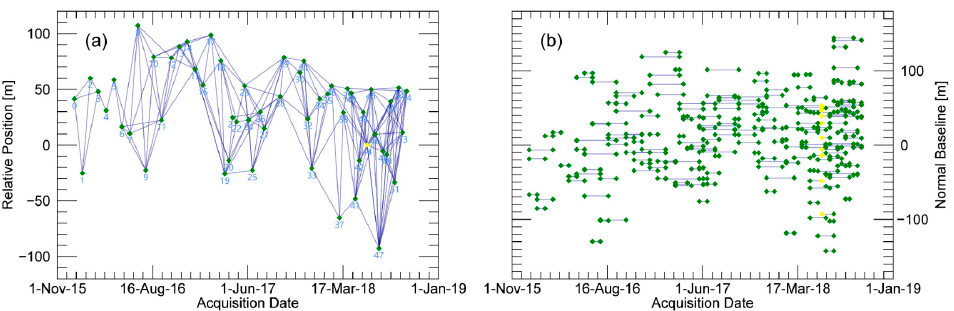
Figure 2. Spatial and temporal baselines of the Sentinel-1A data used in this study. ( a ) The acquisition date and relative position of each SAR image. ( b ) Temporal baseline of the interferometric pair. The yellow point indicates the super master image, and the connecting line indicates that the two images form an interferometric pair.